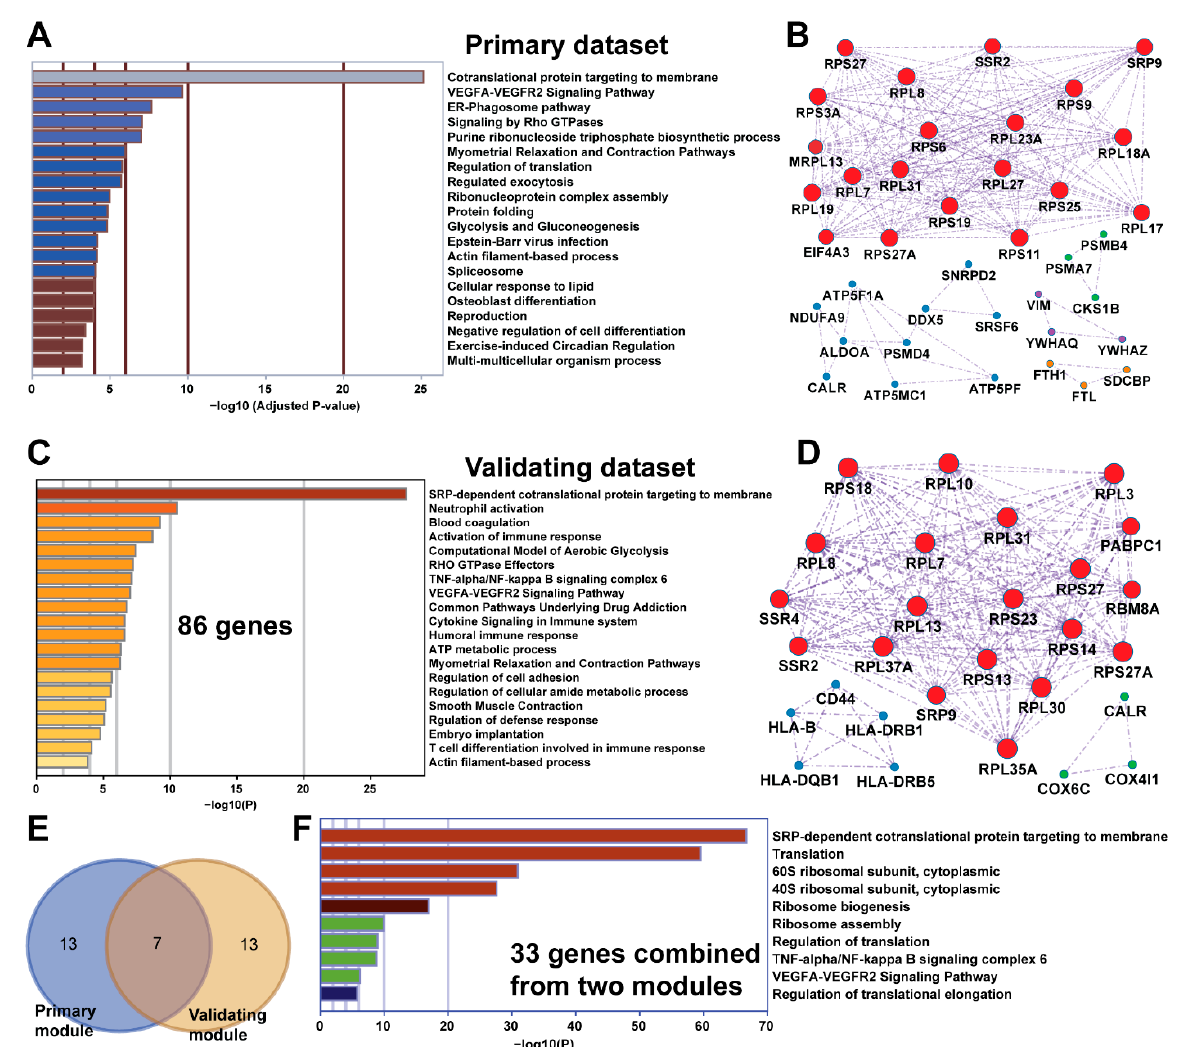
Figure 2. Functional analysis of two top-ranked gene lists with concordant copy number gain and upregulation (CNG-UP) genes. ( A ) The bar plot shows the gene ontology (GO) cluster representatives for the 94 CNG-UP genes from the primary scRNAseq dataset. The x -axis indicates the log of corrected p -values. ( B ) The five functional modules-based gene–gene interactions for the 94 CNG-UP genes from the primary scRNAseq dataset. The different colors represent the five identified functional modules. The top ranked modules related to cotranslational protein targeting membranes are depicted in red nodes. Four other identified modules are purine ribonucleoside triphosphate biosynthetic processes (blue nodes), SCF(Skp2)-mediated degradation of p27/p21 (green nodes), apoptosis (purple nodes), and neutrophil degranulation (orange nodes). ( C ) The representative GO clusters for 86 CNG-UP genes from the validating dataset. The x -axis indicates the log of corrected p -values. ( D ) Three functional modules summarized from gene–gene interactions for the 86 CNG-UP genes from the validating dataset. The top three ranked modules are SRP-dependent cotranslational protein targeting to membranes (in red), the interferon-gamma-mediated signaling pathway (in blue), and cellular responses to stress (in green). ( E ) Overlapping of the top-ranked modules associated with protein targeting from primary and validating datasets. Seven genes are shared in both modules. ( F ) The representative GO clusters for 33 CNG-UP genes related to SRP-dependent cotranslational protein targeting to membranes combined from the primary and validating datasets. The x -axis indicates the log of corrected p -values.